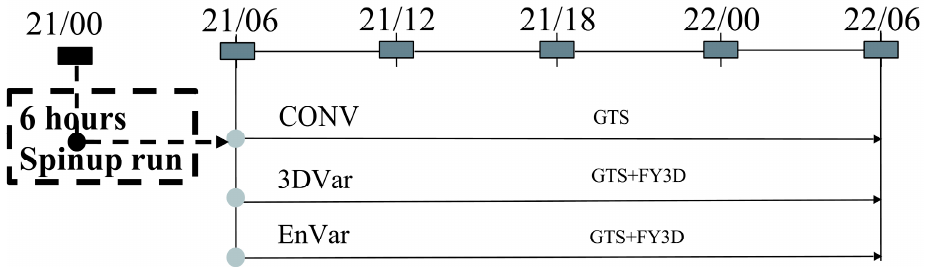
Figure 3. Flow chart of experiments.